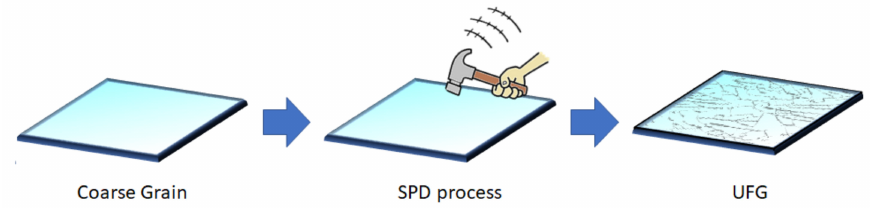
Figure 1. The severe plastic deformation (SPD) process can be thought of as the impact of a hammer on a window